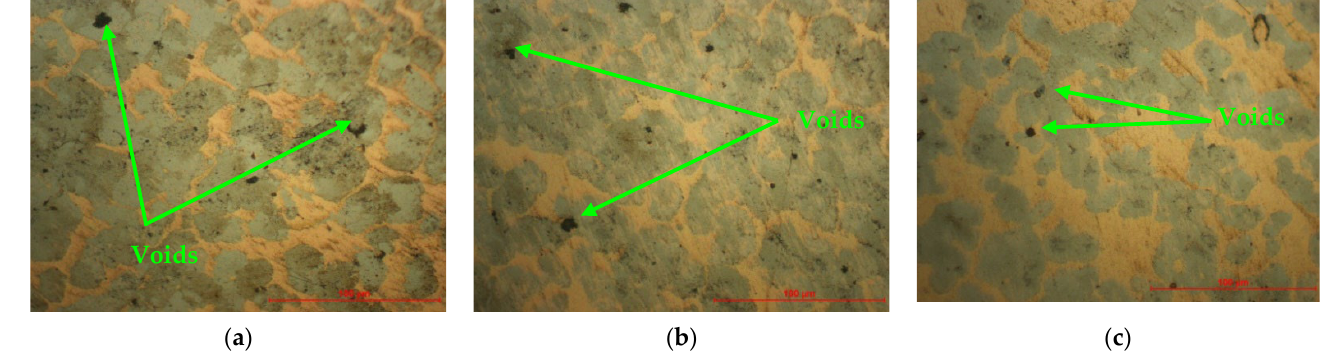
Figure 8. Microscopic analysis of specimens manufactured by the SLS process: ( a ) Section 1; ( b ) Section 2; ( c ) Section 3.